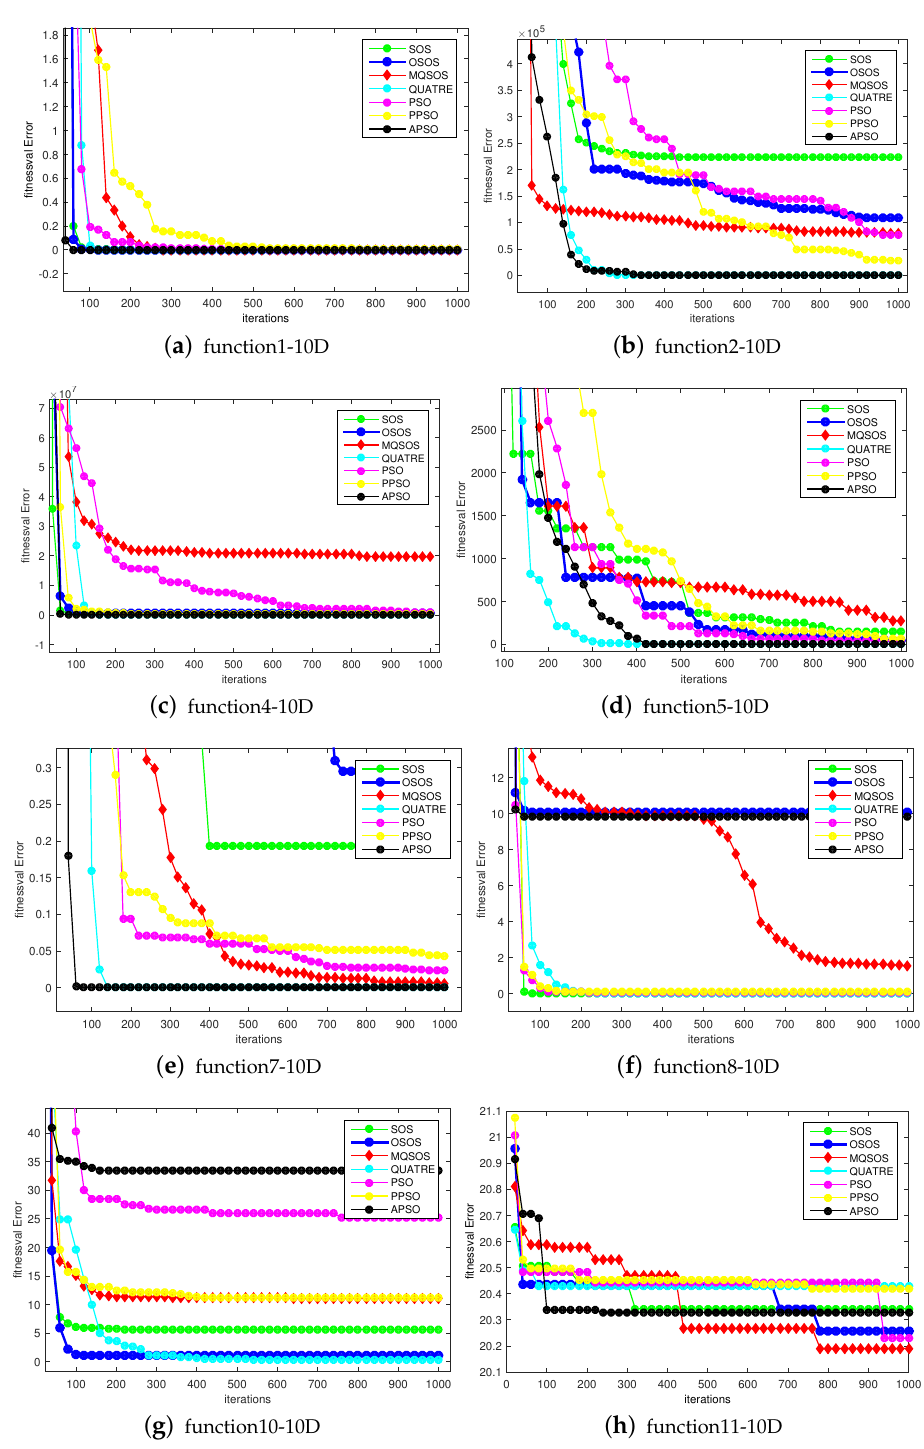
Figure 2. Comparison of the best fitnesses for functions f 1 − f 8 with 10D